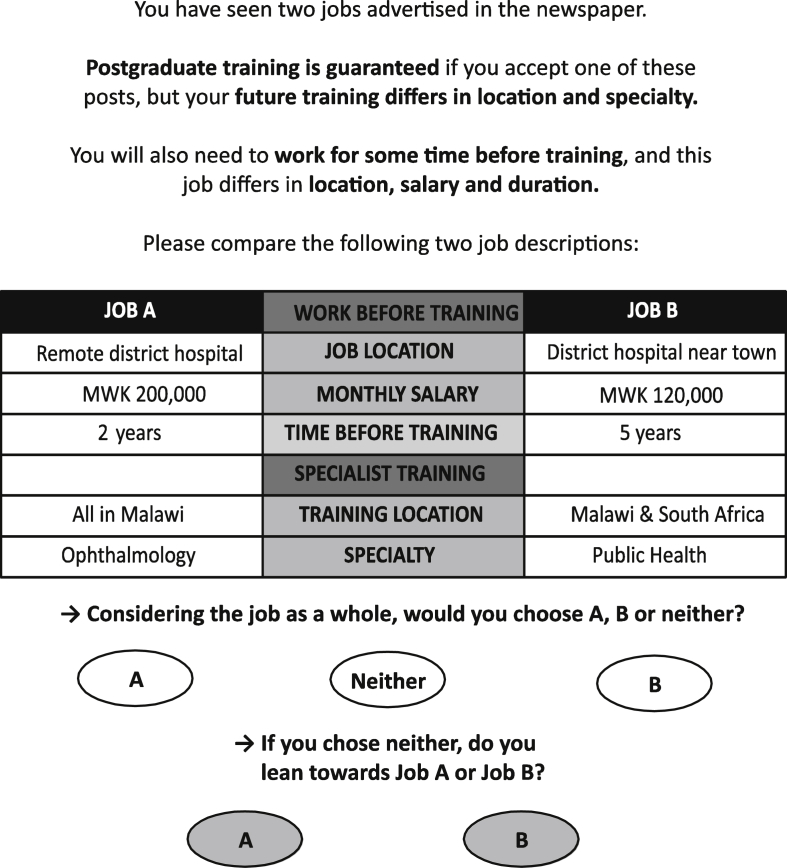
An example choice task.